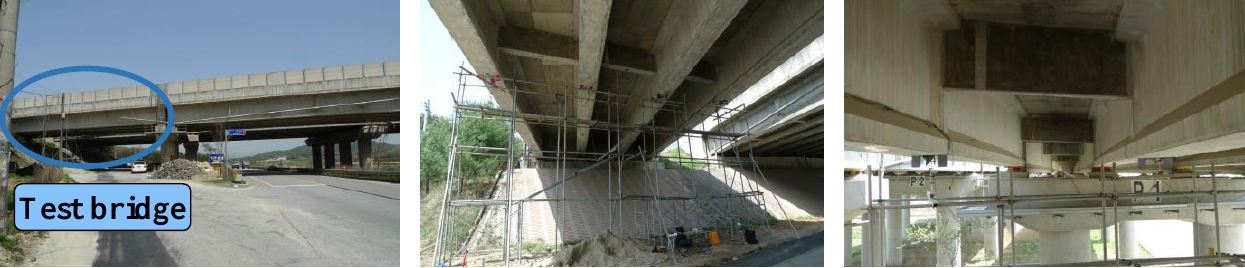
Figure 3. PSC I girder bridge.